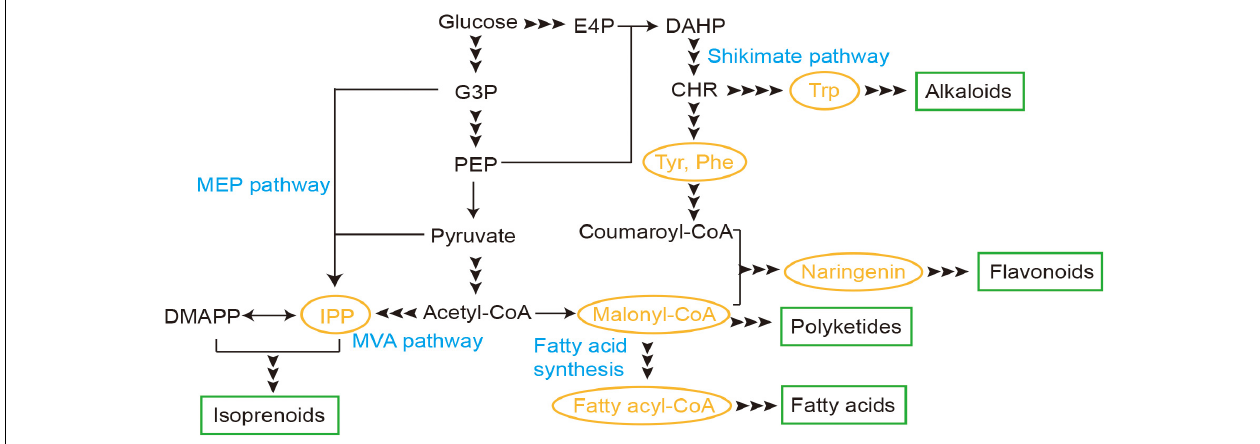
FIGURE 1 | Transcription factor (TF)-based biosensors involved in synthesis pathways of natural products in yeast. E4P, erythrose-4-phosphate; G3P, glyceraldehyde-3-phosphate; PEP, phosphoenolpyruvate; IPP, isopentenyl pyrophosphate; DMAPP, dimethylallyl pyrophosphate; DAHP,